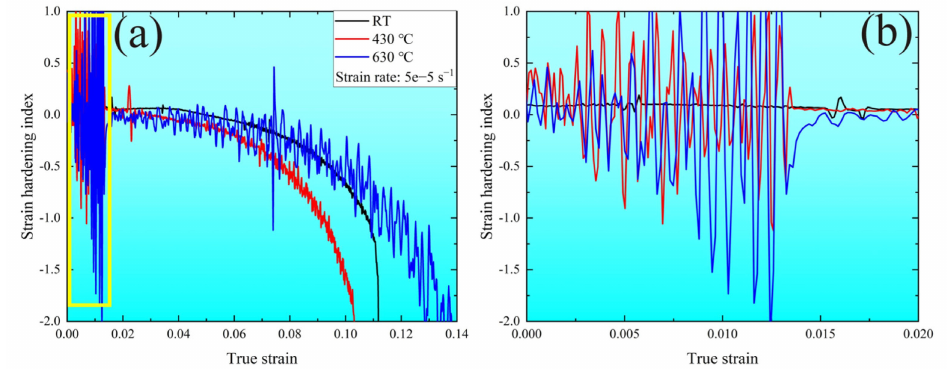
Figure 5. ( a ) The strain hardening index at various temperatures; ( b ) the enlarged image for the yellow rectangle in ( a